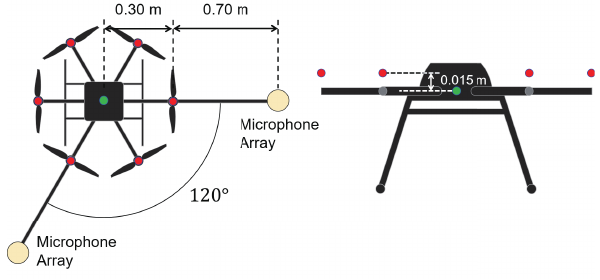
Figure 3. Drone noise source (red dots) in the